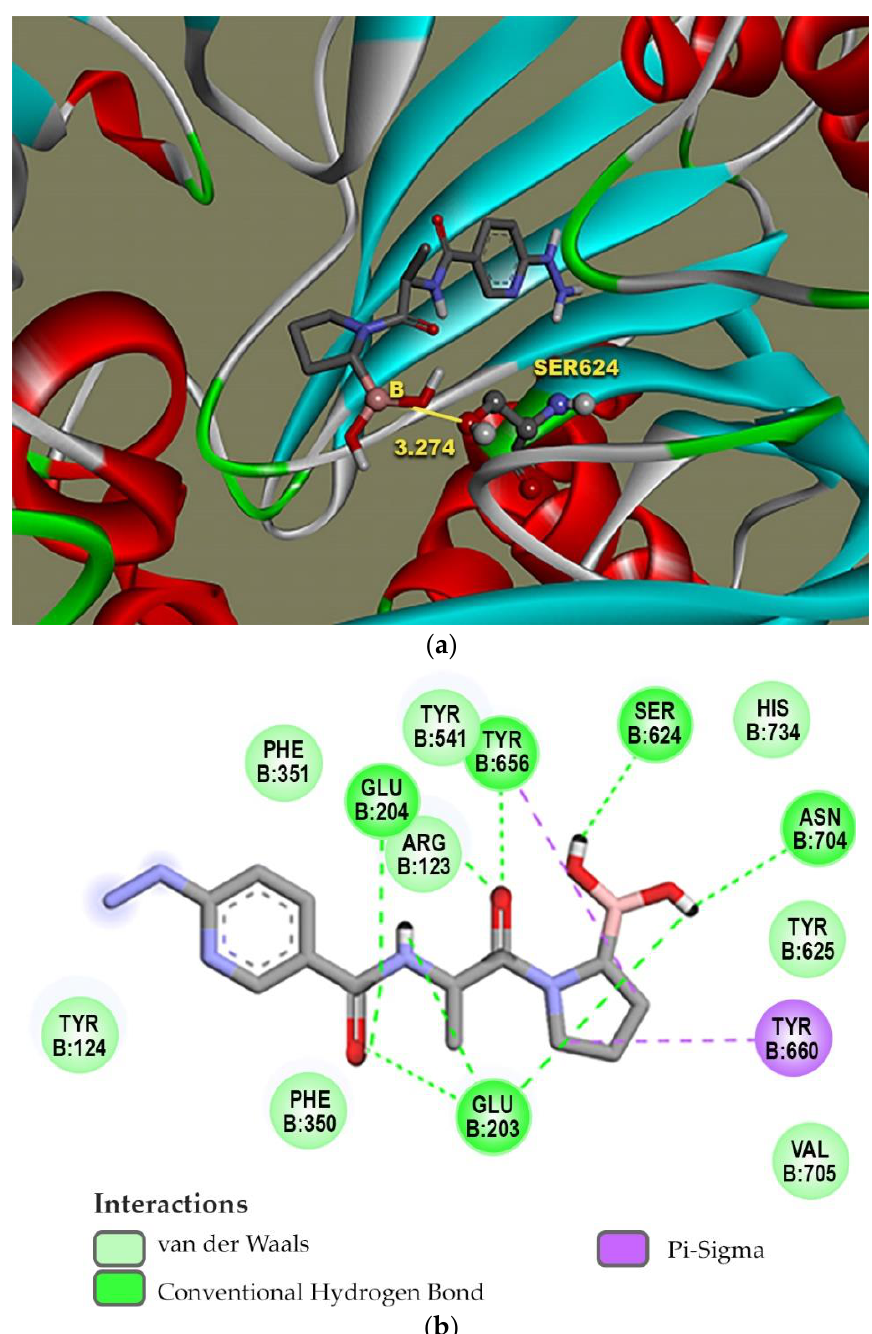
Figure 1. Molecular modeling: ( a ) a FAP ligand-binding cavity for iFAP and ( b ) map of the interac- tions between iFAP and FAP in the ligand binding pocket.